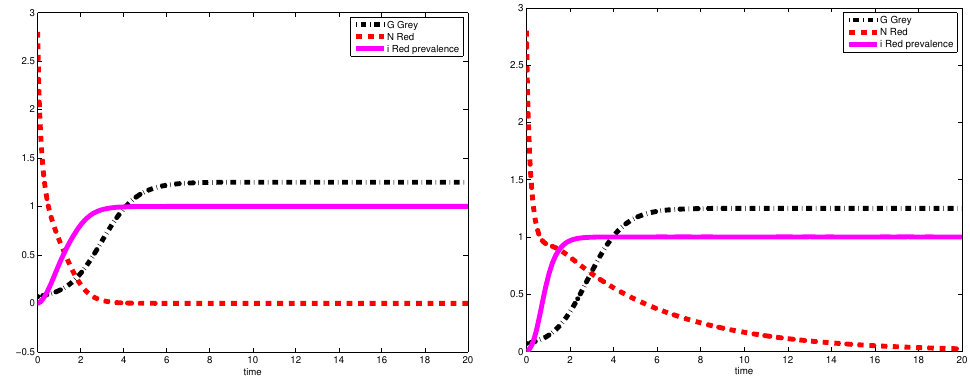
Figure 1. The three populations are plotted versus time: G grey squirrels, dash-dotted; N total red squirrels, dashed; i disease prevalence among red squirrels, continuous line. ( Left frame ) This is the current situation obtained with the basic parameter values (3); red squirrels are wiped out. ( Right frame ) This is the situation with the basic parameter values (3), but taking a much lower value of the natural plus disease-related mortality µ = 0.2, one tenth of the previous one. In both cases, it is apparent that the red squirrel population is doomed, disappearing while all individuals contract the epidemics. Only the speed of its disappearance varies, being lower for lower mortality rates.